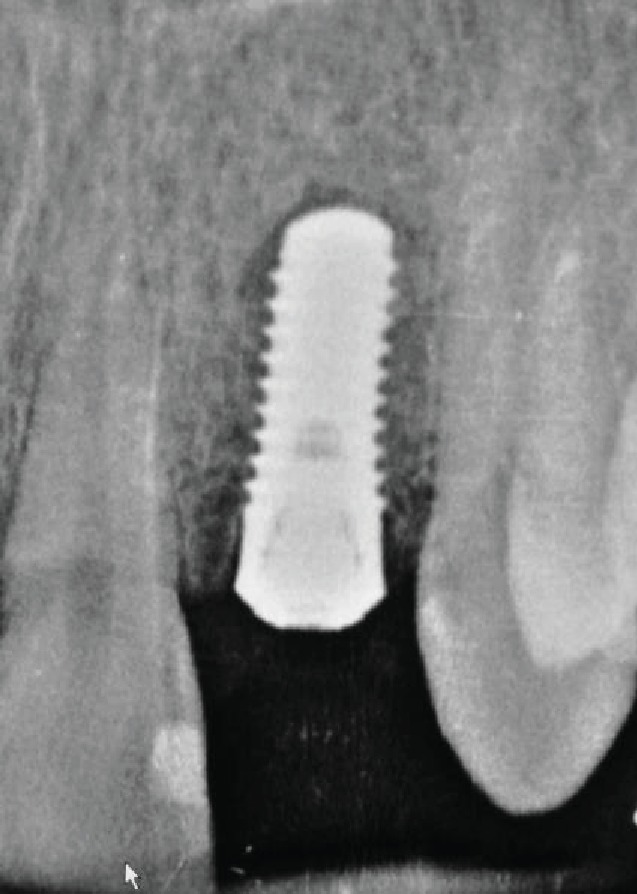
Postoperative X-ray.